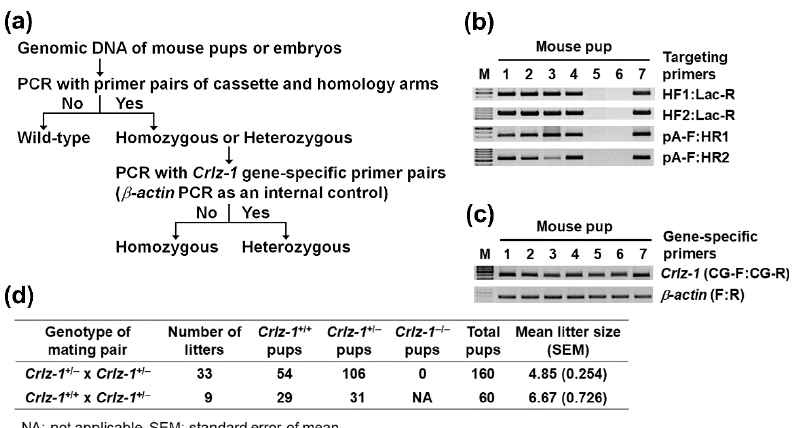
Figure 2. Crlz-1 − / − homozygous null KO pups were not born from the mating pairs of Crlz-1 +/ − heterozygous KO mice by themselves. ( a ) A scheme of PCR genotyping strategy is drawn. ( b ) PCR using the genomic DNA extracted from the tails of pups was performed with the primers indicated over the cassette-targeted Crlz-1 KO locus in Figure 1 to analyze whether the Crlz-1 locus was targeted by the ZEN-UB1 cassette, although it could not still be said which embryos were heterozygously or homozygously targeted. The representative genotyping PCR results from a litter are shown, where #1–4 and #7 pups are found to be targeted, but #5–6 pups are wild-type. ( c ) PCR using the same genomic DNA as in panel b was performed with the primer pairs specific for Crlz-1 and β -actin genes to determine which pups were homozygously targeted, as judged by the absence of Crlz-1 gene despite the presence of β -actin gene as an internal control. The representative genotyping PCR results from the same litter as in panel b are shown, where all the targeted pups, i.e., #1–4 and #7 pups, are found to be heterozygous. ( d ) The genotyping results of 160 pups from 33 litters born in the matings of Crlz-1 +/ − heterozygous KO mice by themselves, as analyzed in panels b and c, are summarized in the top row of the table. Those of 60 pups from 9 litters born from the matings between Crlz-1 +/+ wild-type and Crlz-1 +/ − heterozygous mice are also included in the bottom row as a control. M: DNA size